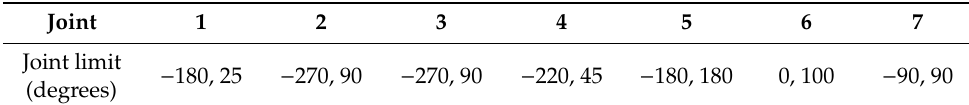
Table 1. Constraints of joints.